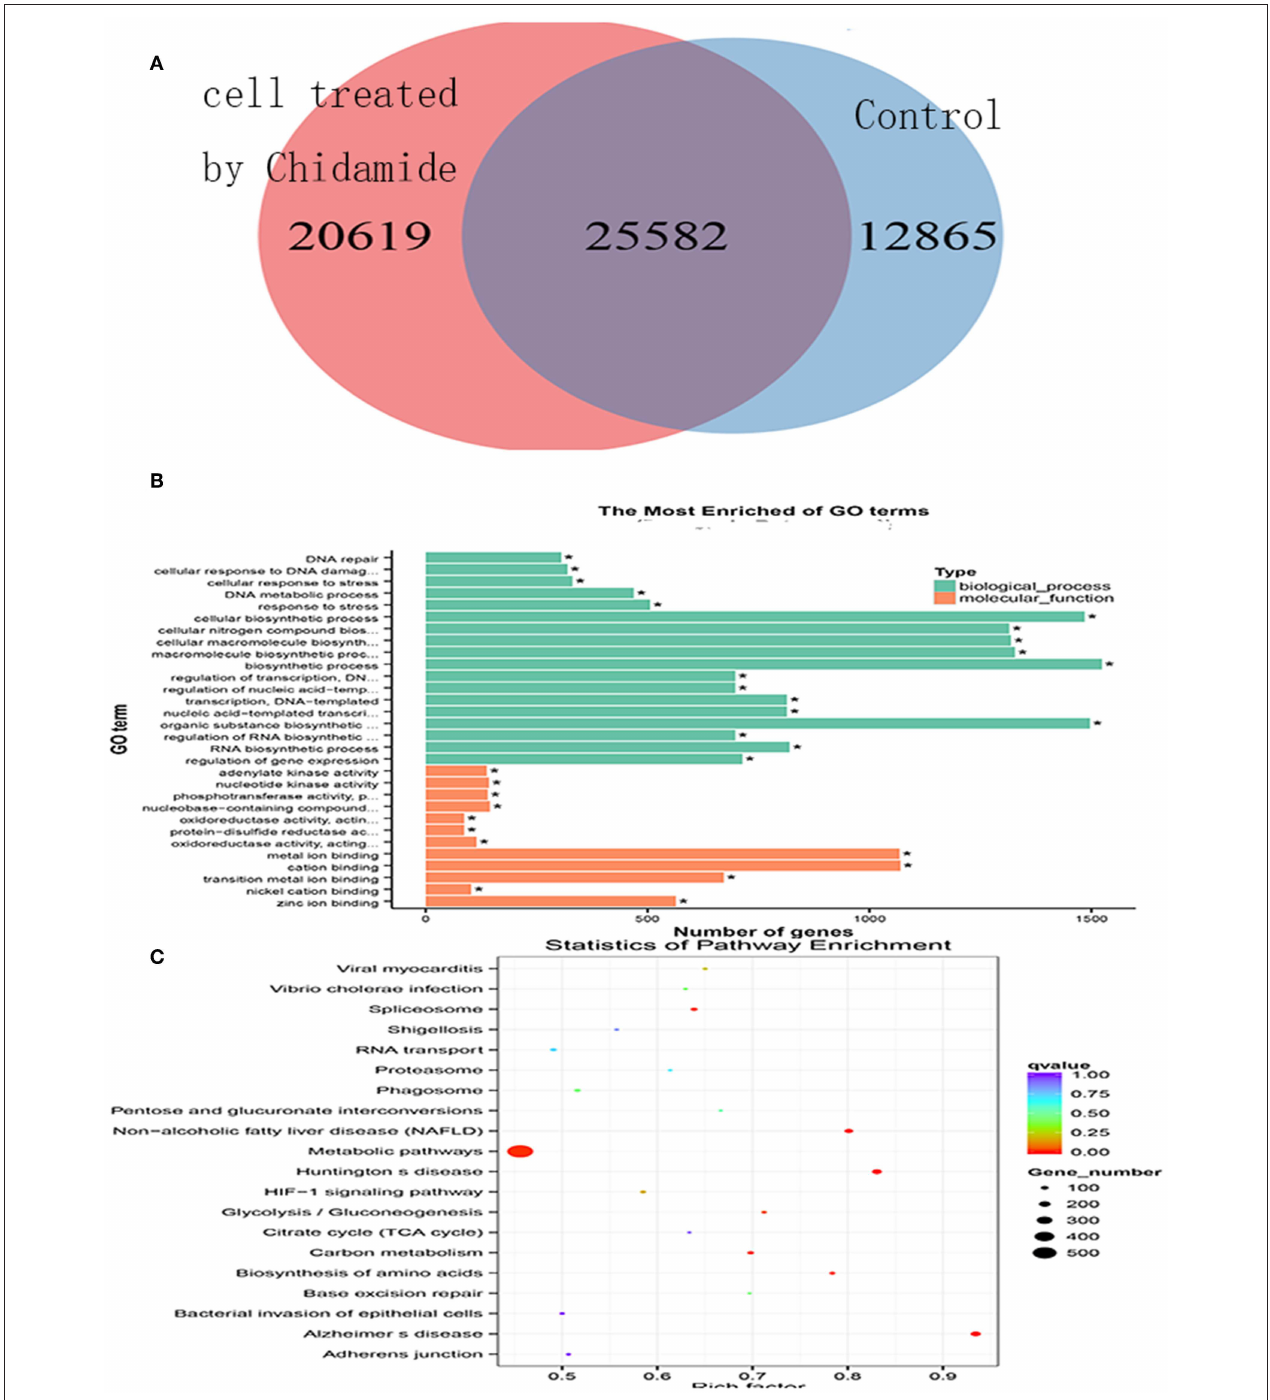
FIGURE 3 | Chromatin immunoprecipitation sequencing in chidamide-treated THP-1 cells. (A) A Venn diagram showing the differential expression of H3K9me3 in chidamide-treated THP-1 cells compared with the control (untreated) cells, and there was differential expression in the two teams. (B) The results of GO and KEGG enrichment analyses showing the potential changes in signaling pathways for biological processes and molecular functions in chidamide-treated acute myeloid leukemia cells compared with control (untreated) cells. Among the biological processes, we identified several significantly different potential mechanisms, such as DNA repair, cellular response to DNA damage, and stress response. Regarding molecular functions, we also found several significantly different potential mechanisms, such as adenylate kinase activity, and nucleotide kinase activity. (C) The results of bubble chart analyses that were performed by GO and KEGG enrichment also showed that the numbers of genes in metabolic pathway were the